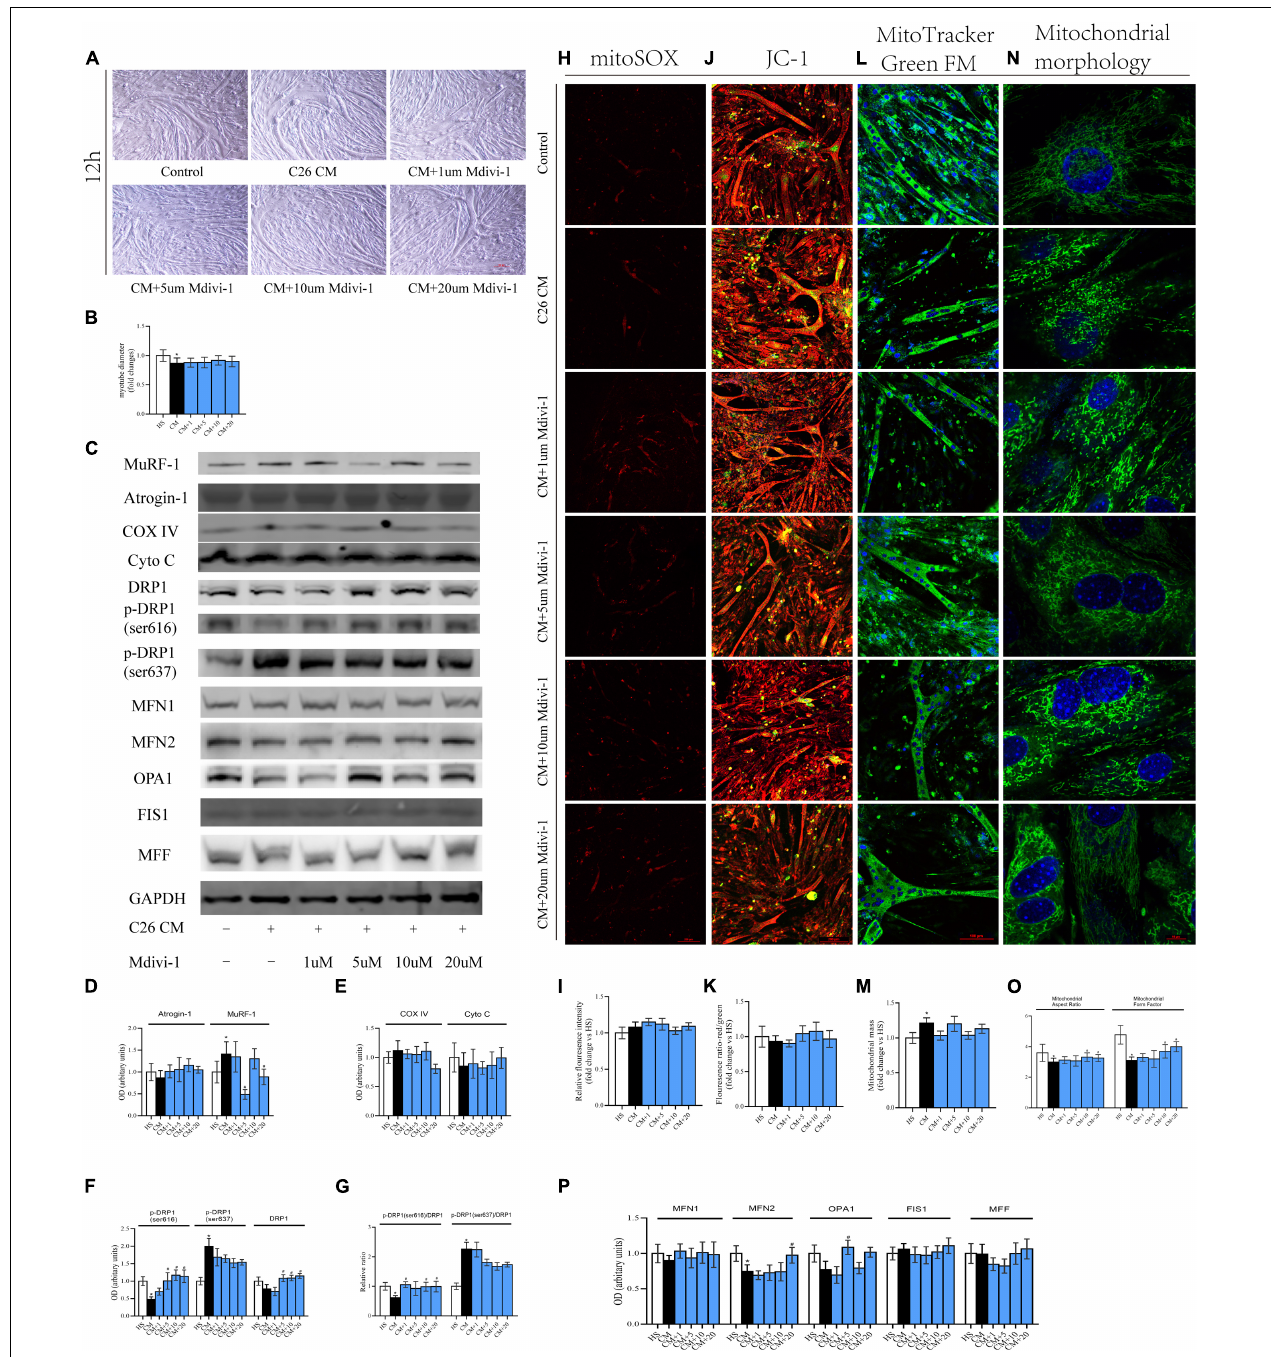
FIGURE 4 | (A) Typical images of the C2C12 myotube cocultured with CM for 12 h. (B) Quantification of myotube diameter. (C) Levels of Atrogin-1, MuRF-1, DRP1, p-DRP1(ser616), p-DRP1(ser637), Cyto C, COX IV, and GAPDH by Western blot. (D) Quantification of Atrogin-1 and MuRF-1. (E) Quantification of Cyto C and COX IV. (F) Quantification of DRP1, p-DRP1(ser616), and p-DRP1(ser637). (G) Quantification of p-DRP1(ser616)/DRP1 and p-DRP1(ser637)/DRP1 ratio. (H) Typical images to analyze mitoROS by mitoSOX. (I) Quantification of mitoSOX with fluorescence ratio (Ex/Em = 510/580 nm). (J) Typical images to analyze MMP by JC-1. (K) Quantification of MMP with fluorescence intensity (red/green) ratio by ImageJ software. (L) Typical images to analyze mitochondrial mass by Mito-Tracker Green FM. (M) Quantification of mitochondrial mass with fluorescence intensity by ImageJ software. (N) Typical images to analyze mitochondrial morphology in myoblasts by MitoTracker Green FM. (O) Quantification of mitochondrial morphology by Mitochondrion Analyzer, a plugin of ImageJ software. FF (form factor: the reciprocal of circularity value) and AR (aspect ratio: major axis/minor axis of an ellipse equivalent to the object). (P) Quantification of MFN1, MFN2, OPA1, FIS1, and MFF; control: myotube cultured in DMEM of 2% HS; CM (conditional medium): myotube cultured in DMEM of 33% C26 conditional medium; * p < 0.05 vs. control group; # p < 0.05 vs. CM group. Data are displayed as mean ± standard deviation.